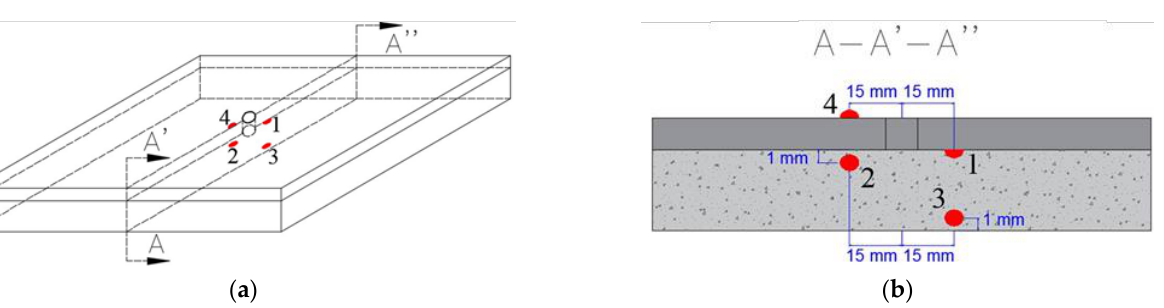
Figure 3. ( a ) Specimens in the process of curing; ( b ) specimen schematic representation and re-